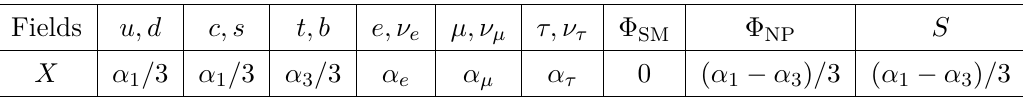
Table 2 . The X -charges of particles in U(1) X